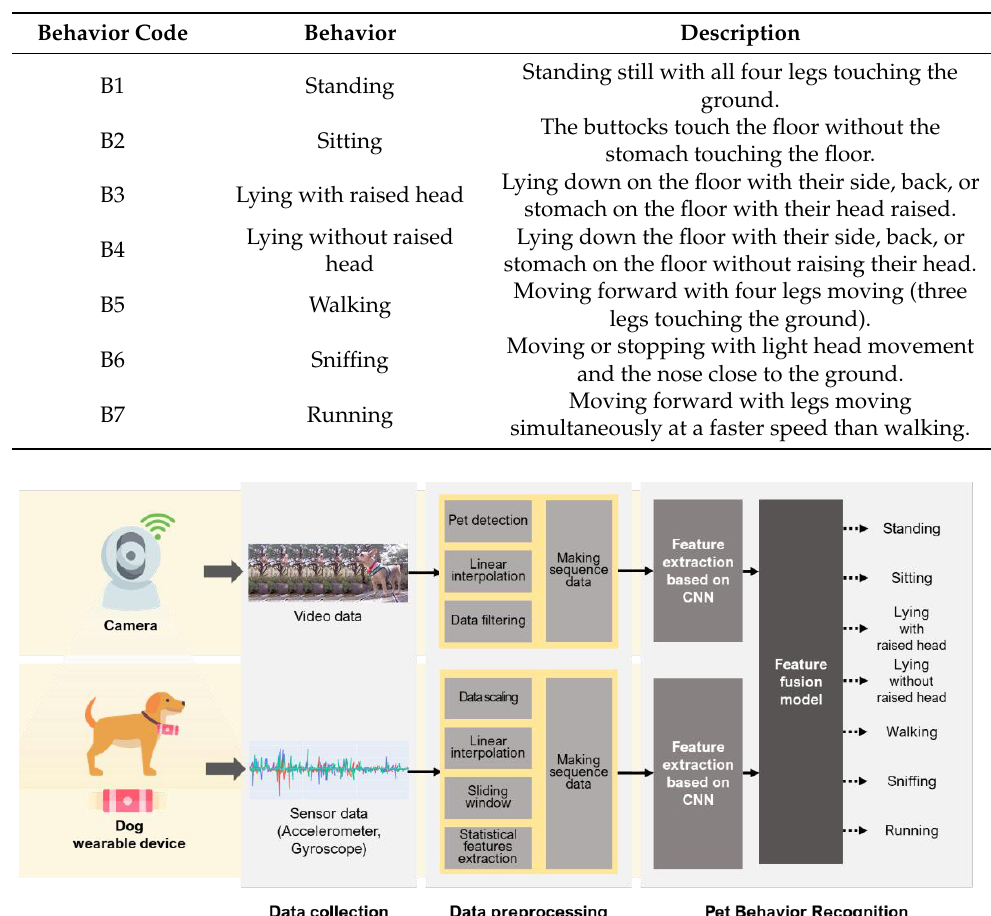
Table 2. Dog behavior to be recognized.